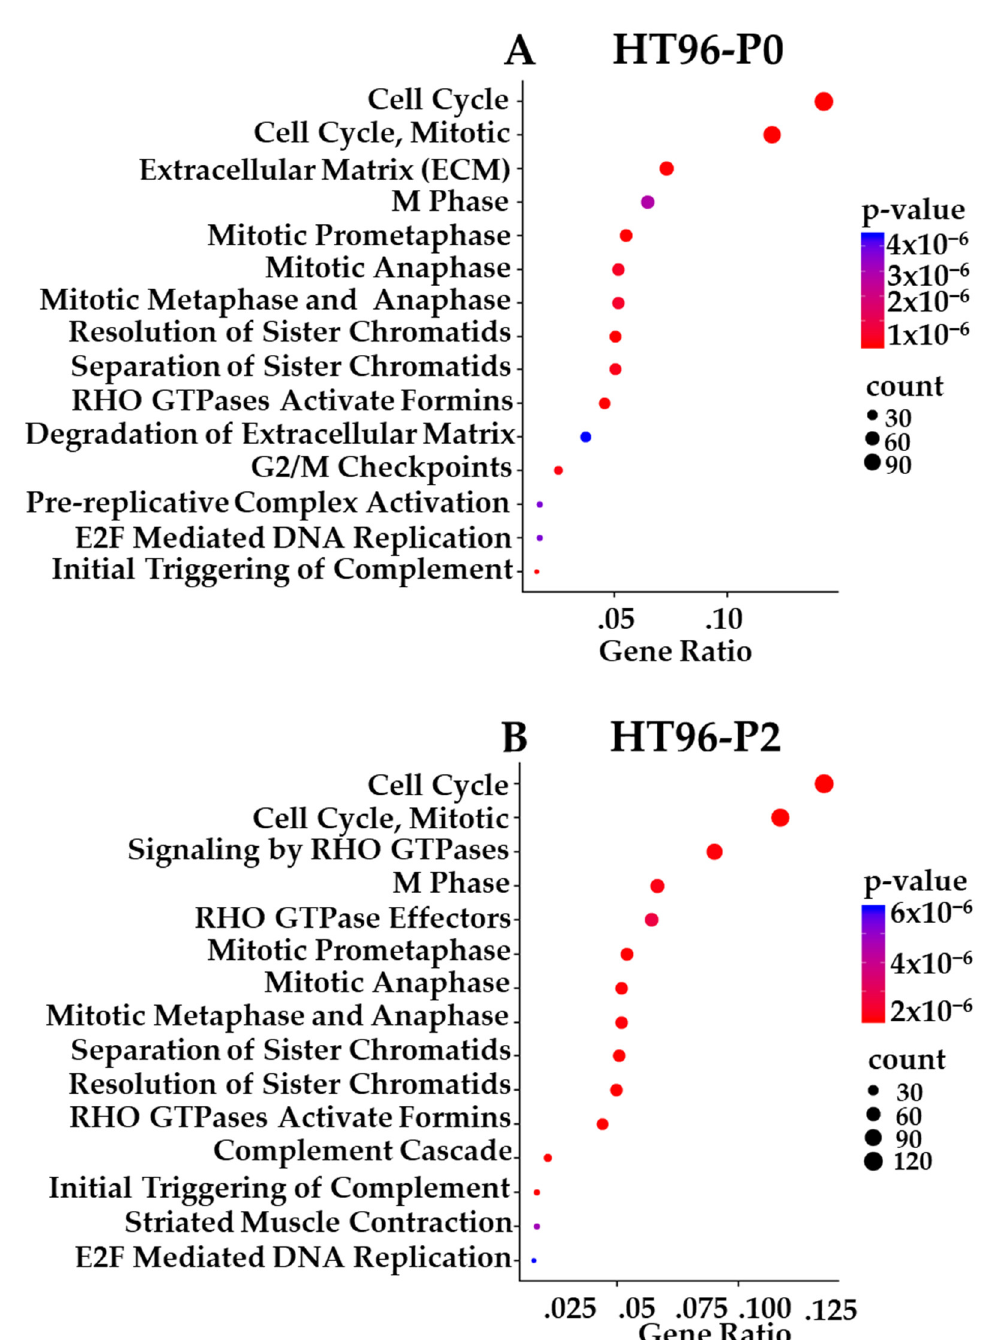
Figure 13. ( A ) HT96-P0 and ( B ) HT96-P2 pathway enrichment analysis highlights cell cycle pathway as a critical player for this PDX and the original tumor (P0). Genes that were statistically significant ( p < 0.05) and >1.5-fold change were selected for pathway enrichment analysis using GO, KEGG, and